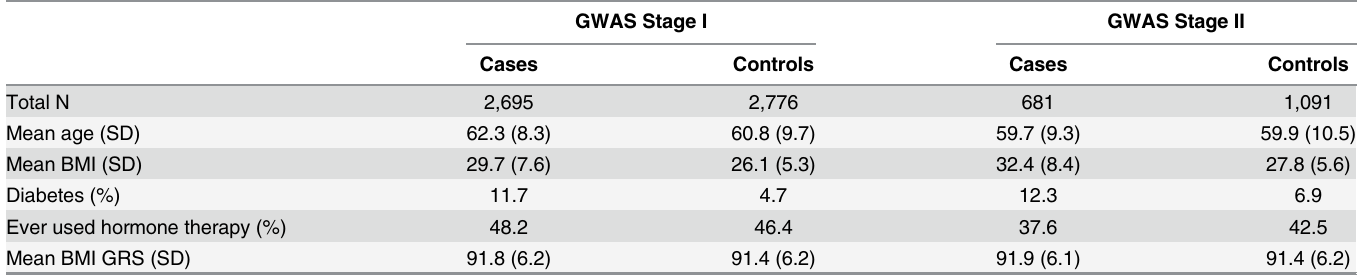
Table 1. Selected Population Characteristics by Genome-Wide Association Study Stage and Case-Control Status Among Women of European